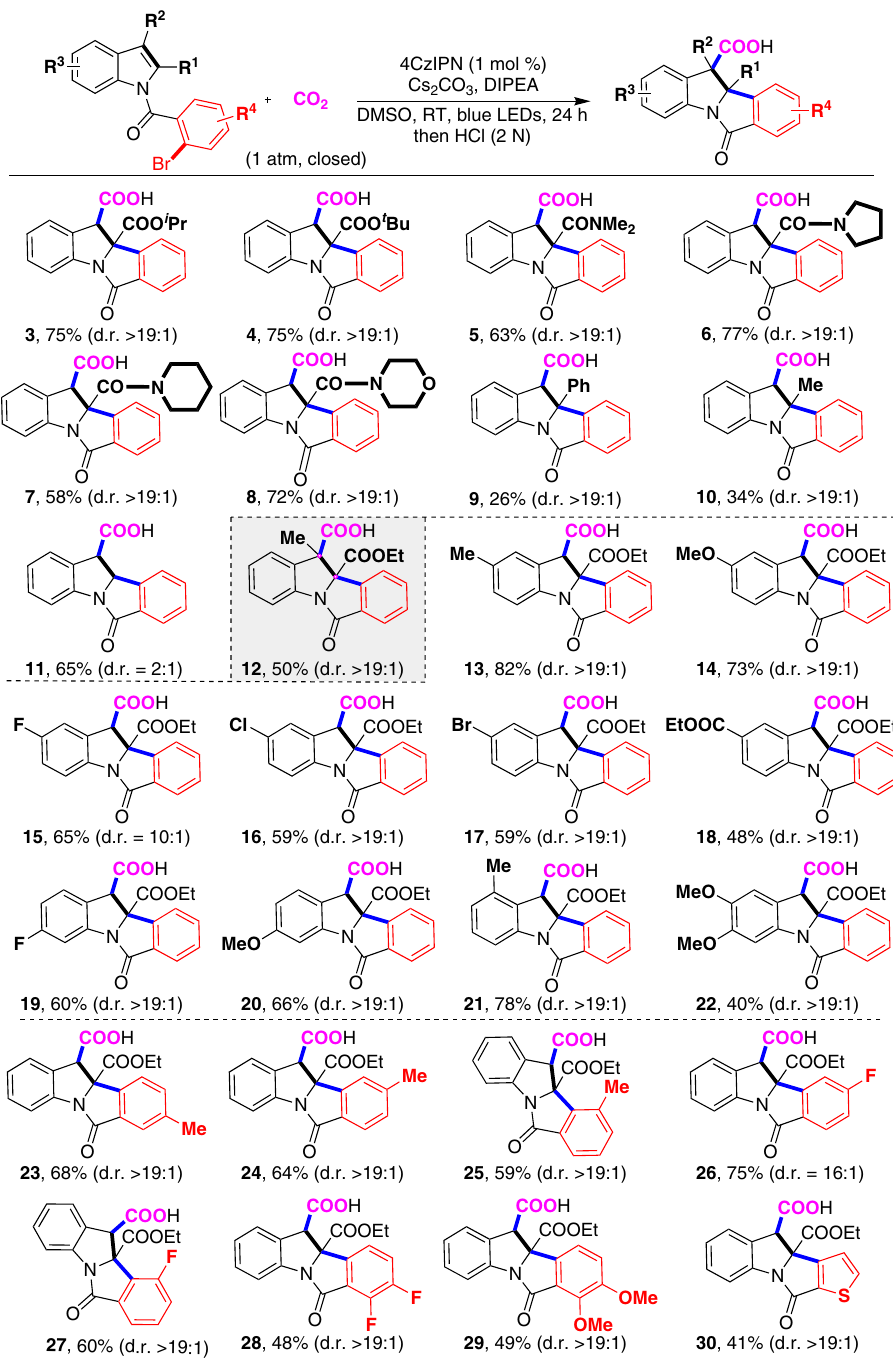
Fig. 3 Scope of substrates with substituents on indoles. The standard reaction conditions were used, as shown in Table 1, entry 1. Isolated yields are